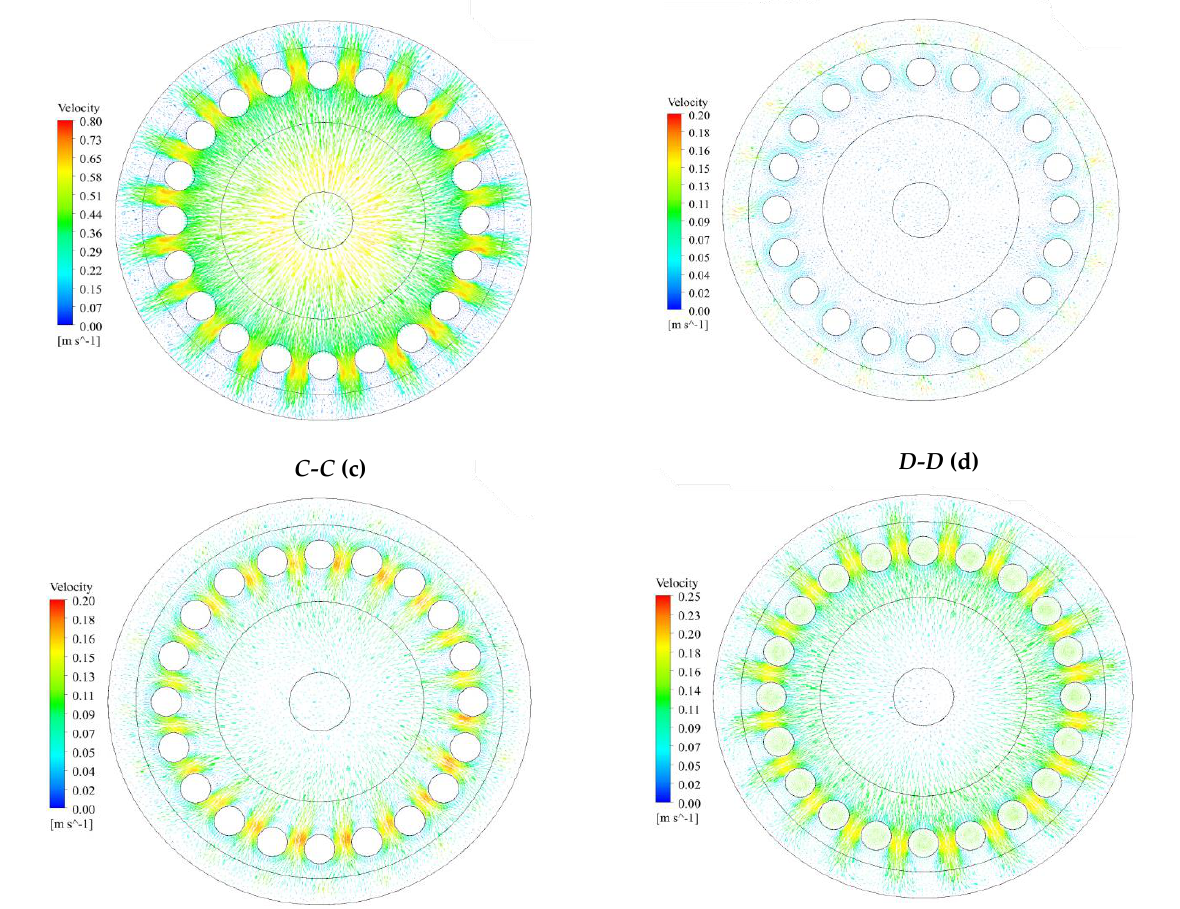
Figure 9. Reactor, Transversal cuts at Z = 65-mm ( A-A ) ( a ), 95-mm ( B-B ) ( b ), 130-mm ( C-C ) ( c ), 175-mm ( D-D ) ( d ).